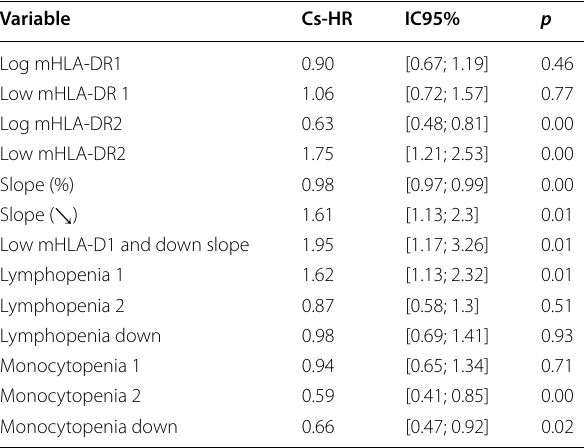
Table 2 Multivariate cause-specific survival model: sensitivity analysis of predictors of secondary infection